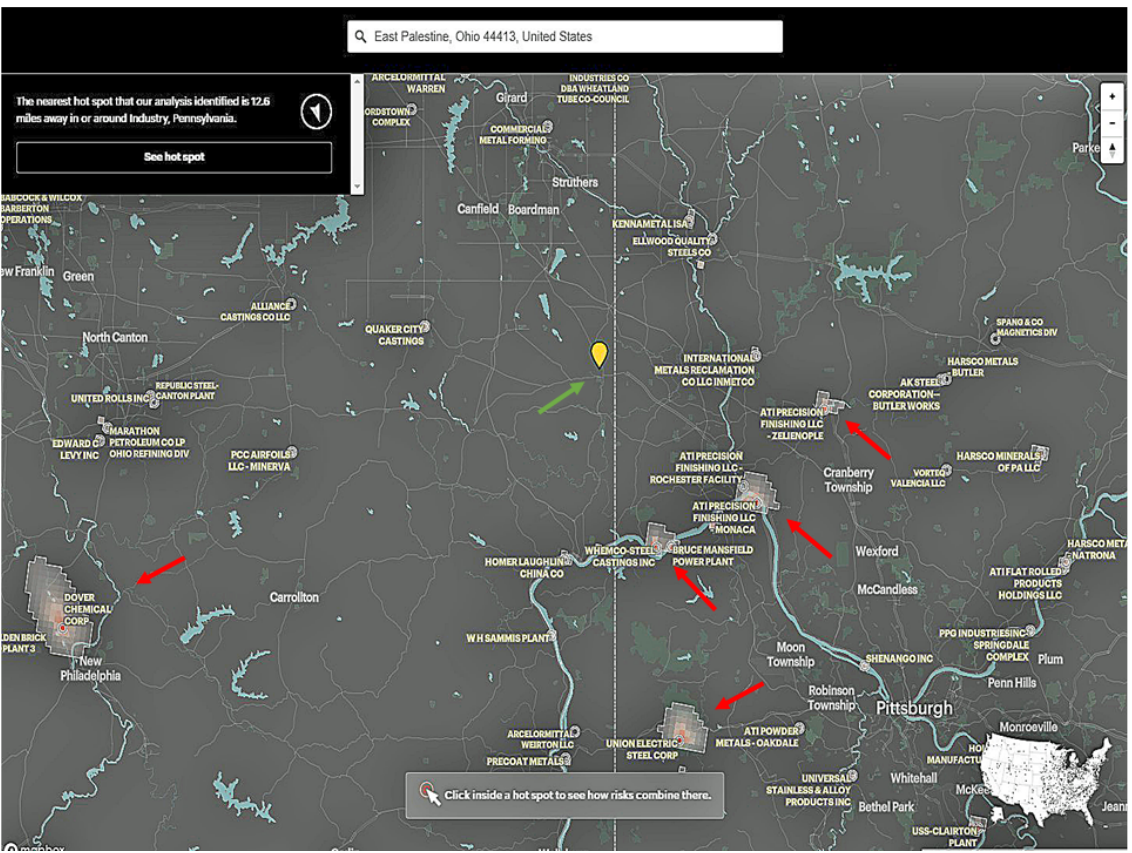
Figure 2. ToxMap showing the area of East Palestine, Ohio (green arrow) and five industrial establishments in the neighborhood, four of which are quite close to Pittsburgh, PA, United States of America. Epidemiologists and public health officials may want to keep this current ToxMap and subsequent data in mind by analyzing the rate of liver tumors in Ohio and Pennsylvania in the near future. ToxMap is a web-based geographic information system (GIS) (http://toxnet.nlm.nih.gov, accessed on 25 March 2023). The red arrows indicate industrial companies that may have an environmental impact in the areas surrounding East Palestine.